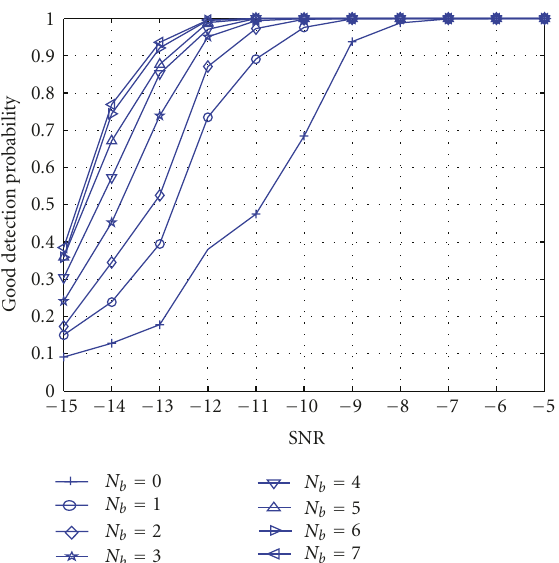
Figure 1: Estimation of the good detection probability for DVB-T signals, mode 8k, with η = 1 / 4 and an observation time equal to 50 milliseconds.